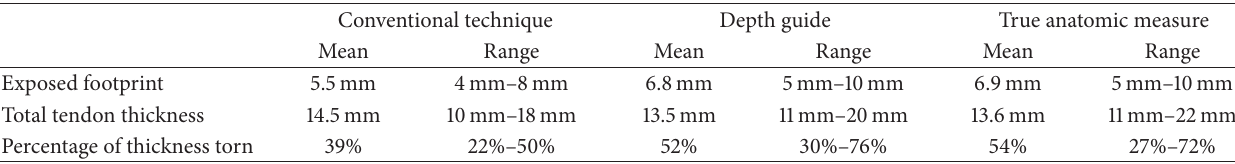
Table 1: Measurements of the exposed footprint, total tendon thickness, and percentage of tendon thickness torn in cadaveric shoulders with simulated partial thickness articular surface rotator cuff tears using the methods of comparison to a known size, the intra-articular depth guide, and true anatomic